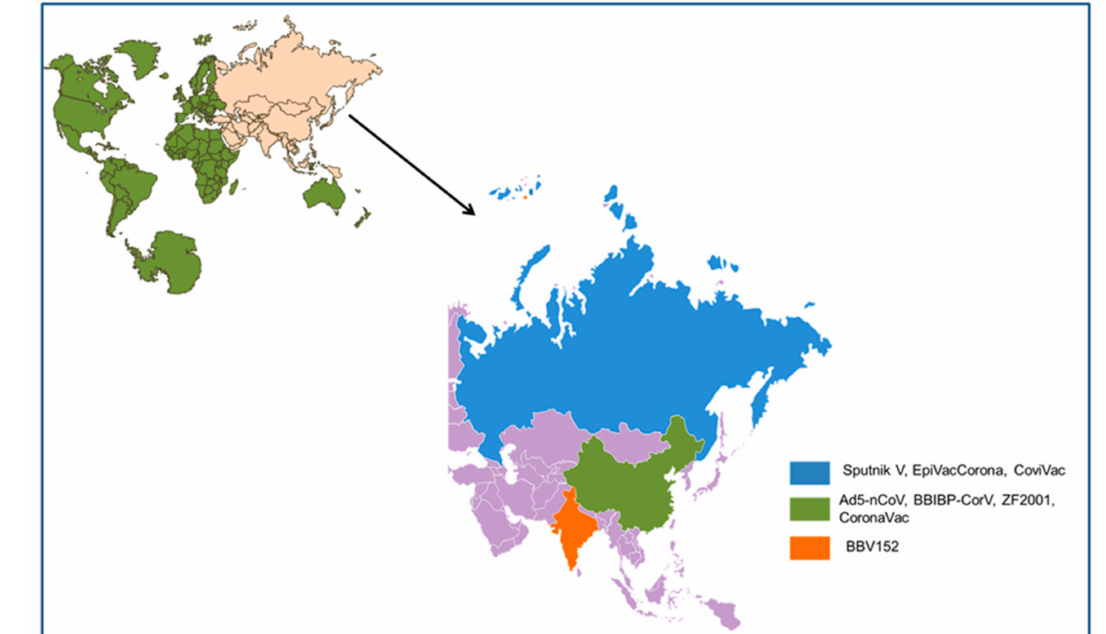
Figure 2. Different Asian-originated COVID-19 vaccines, which received regulatory approval from at least one country and the country of